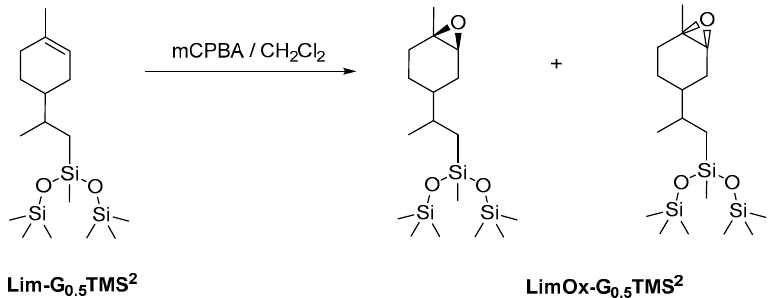
. Figure 1. APT NMR spectrum of LimOx-G 0.5 TMS 2